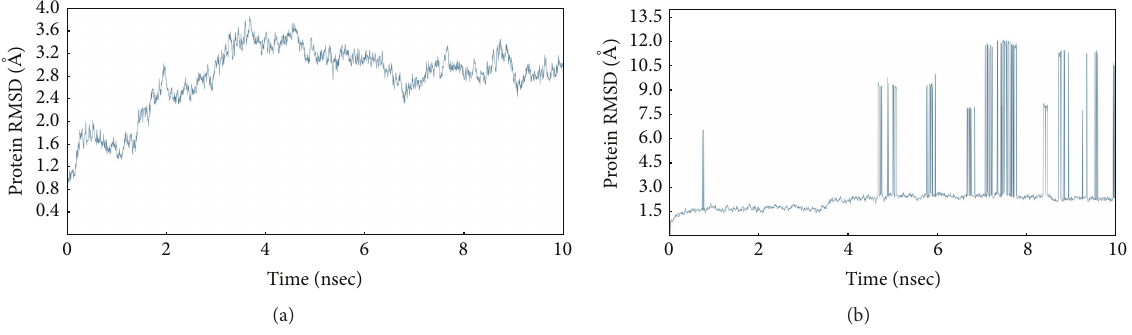
Figure 7: MD simulation of (a) WT protein and (b) alanine mutated protein.